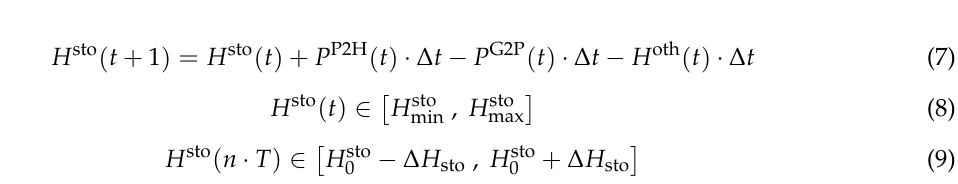
Figure 4. The diagram of accommodating wind power with P2H/G2P.